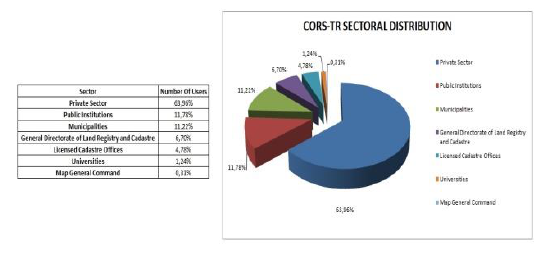
Figure 9. CORS-TR System Users